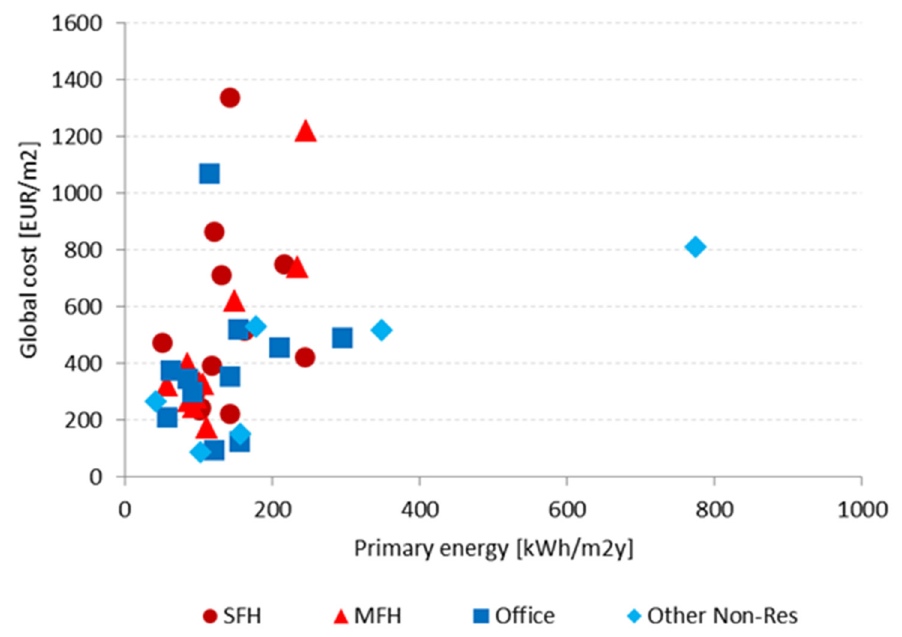
Figure 8. Cost-optimal levels for existing buildings.